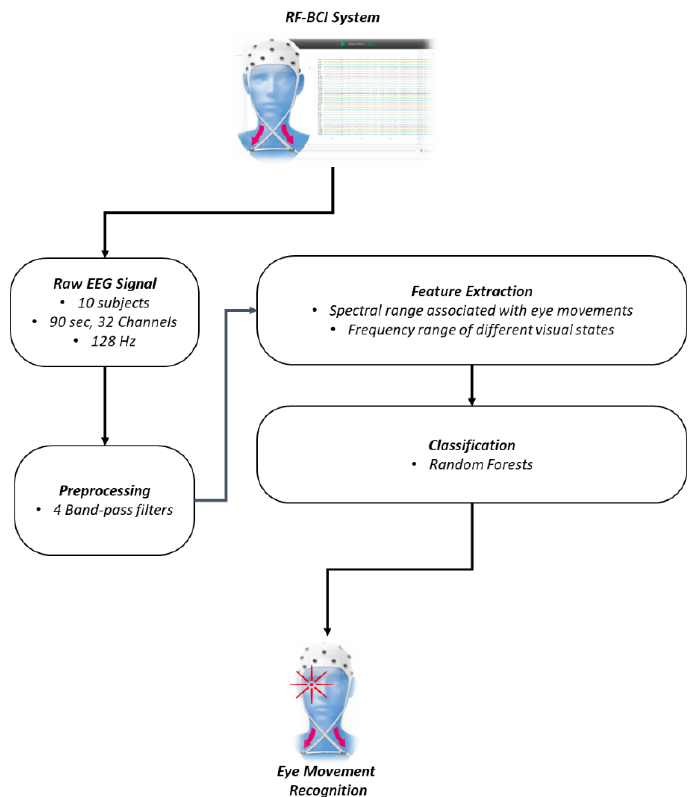
Figure 1. The random forests brain–computer interface (RF-BCI) system architecture. Initially, the EEG signal is captured using the headset and undergoes a preprocessing filtering procedure for removing the unwanted noise and separate the bands. The next step is the feature extraction and the association of each dataset entry with an eye movement. Finally, the dataset is used to train the RF classifier.